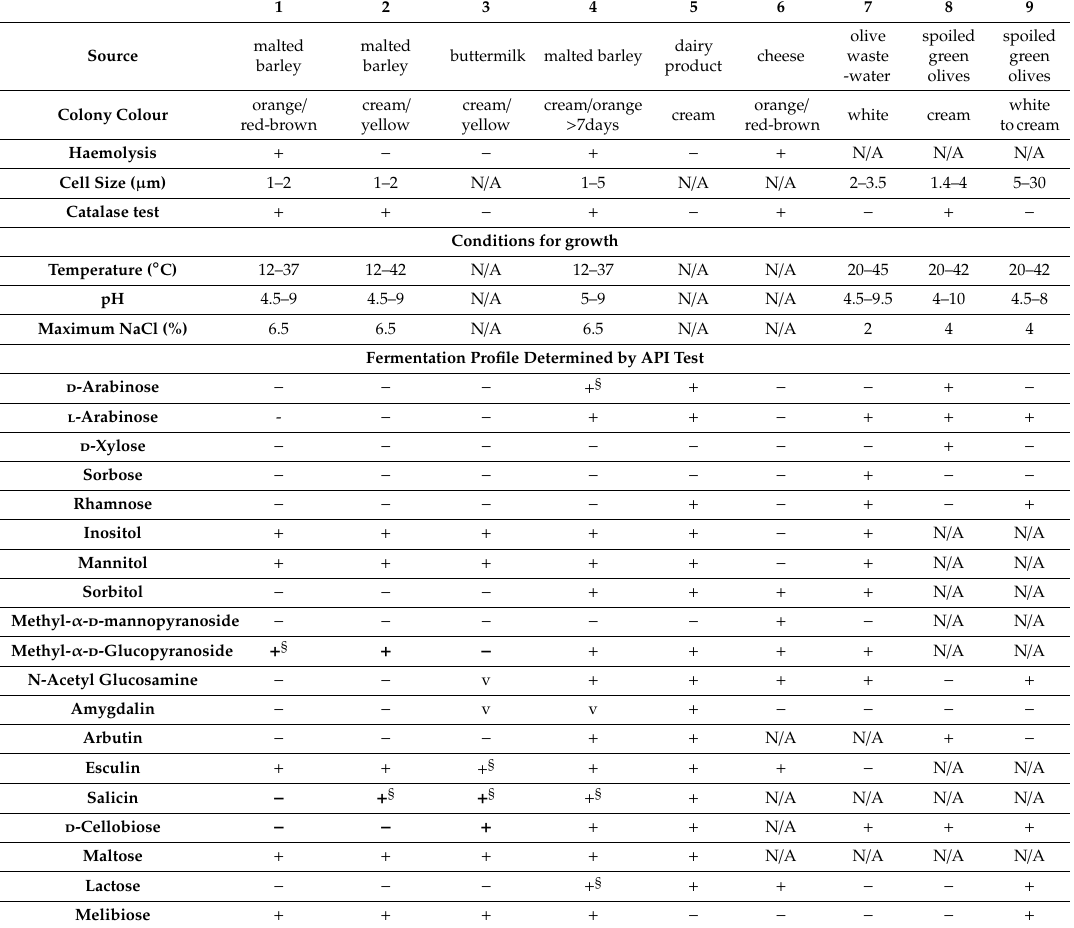
Table 3. Phenotypic comparison of strains JS279 and JS280 with type strains of other species from